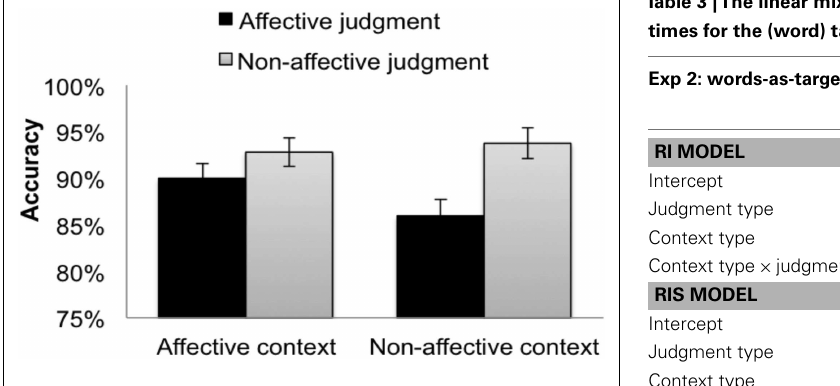
FIGURE 2 |Accuracies for the (word) targets when participants made affective judgments (dark bars) and non-affective judgments (light bars) in the affective context group (left bars) and the non-affective context group (right bars). The error bars indicate subject-wise SEM.